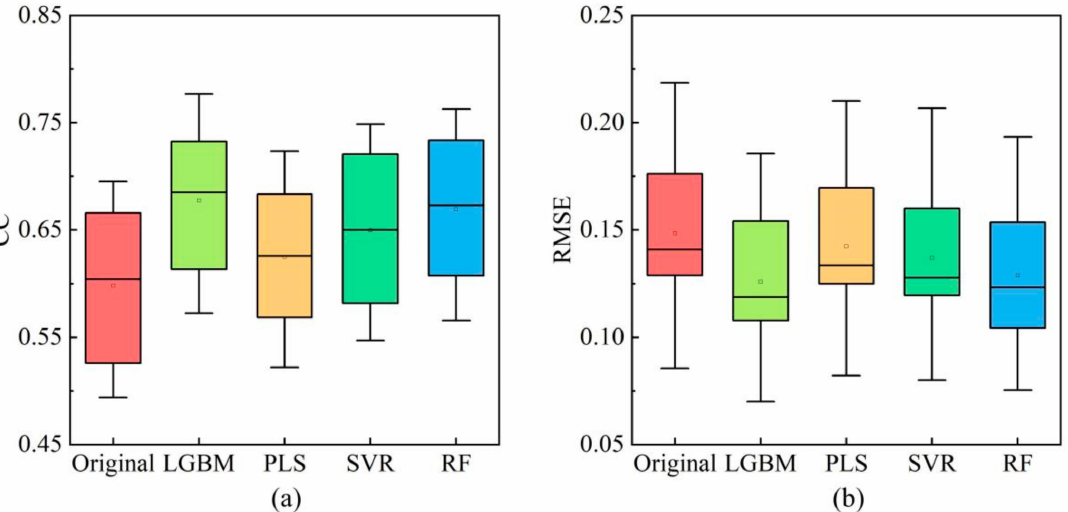
Figure 13. Distribution of MODIS NDVI correction results of four regression methods for three experimental areas. ( a ) CC and ( b ) RMSE.